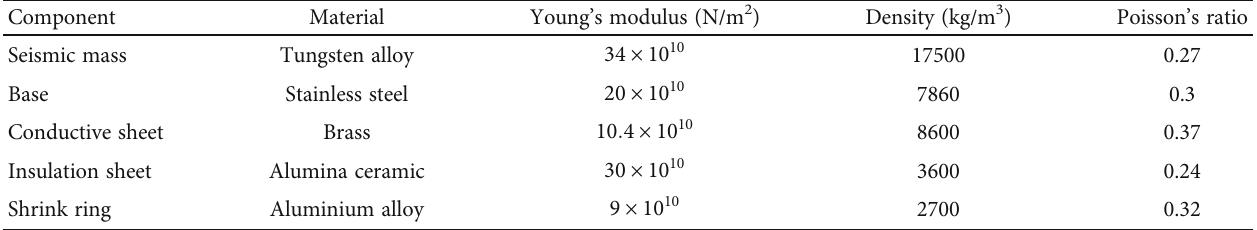
Table 1: The speci fi c nonpiezoelectric materials and their properties of the designed sensor.